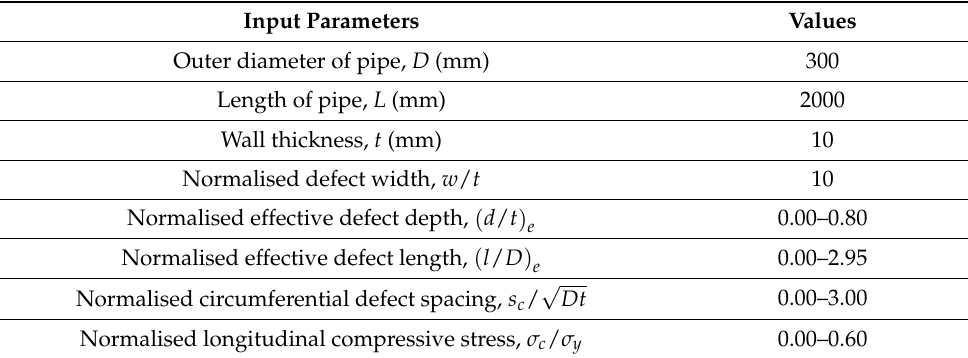
Table 4. Geometric parameters of the corroded pipe